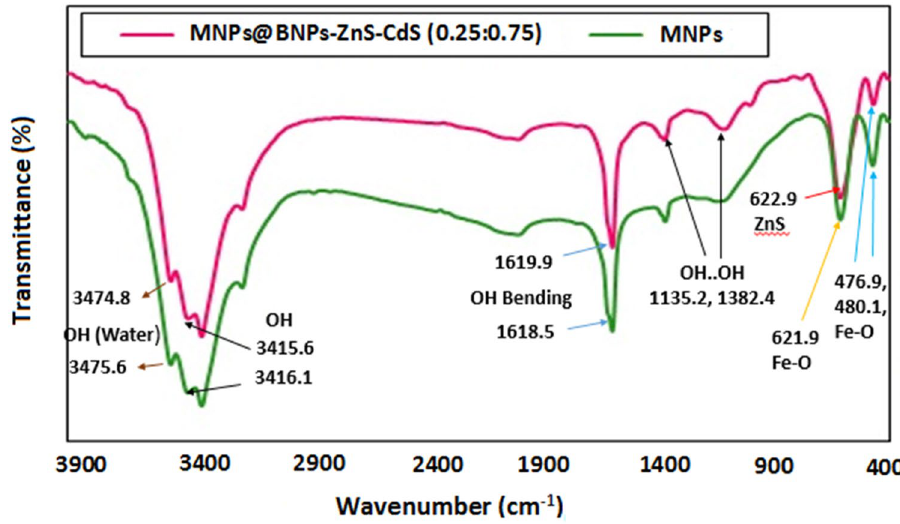
Figure 2. FT-IR spectra of MNPs and Fe 3 O 4 @BNPs@ZnS-CdS.